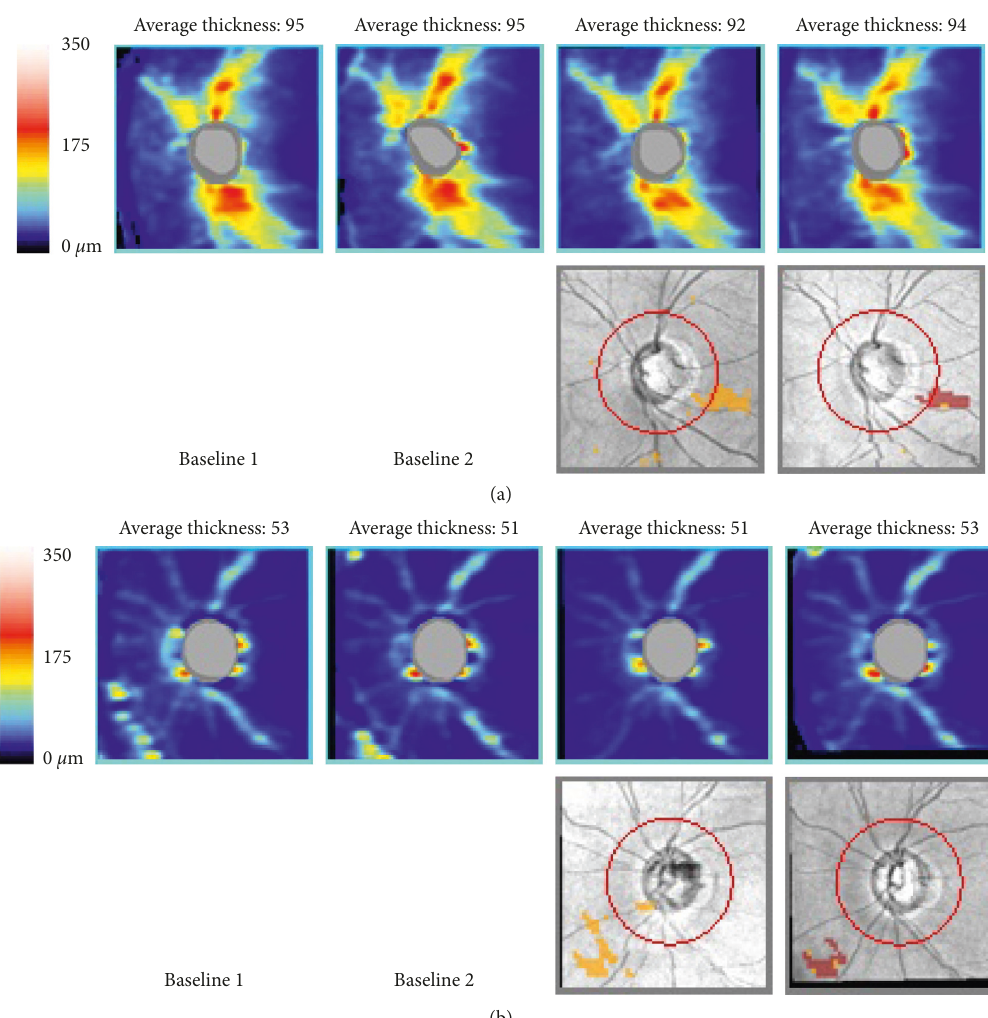
Figure 2: Progressive thinning of the retinal nerve fiber layer (RNFL). Guided Progression analysis (GPA) detected progression of RNFL thinning. (a) 71-year-old man with open-angle glaucoma. (b) 68-year-old man with open-angle